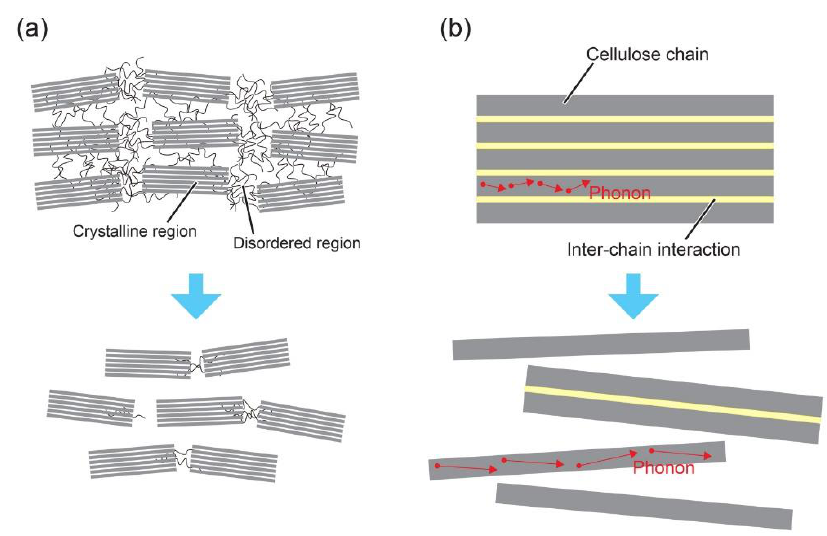
Figure 3. The two major factors that bring in the superior thermal conductivity of nanocelluloses (NCs). ( a ) Diminished amorphous regions; ( b ) Fewer frequency of inter-chain interactions.